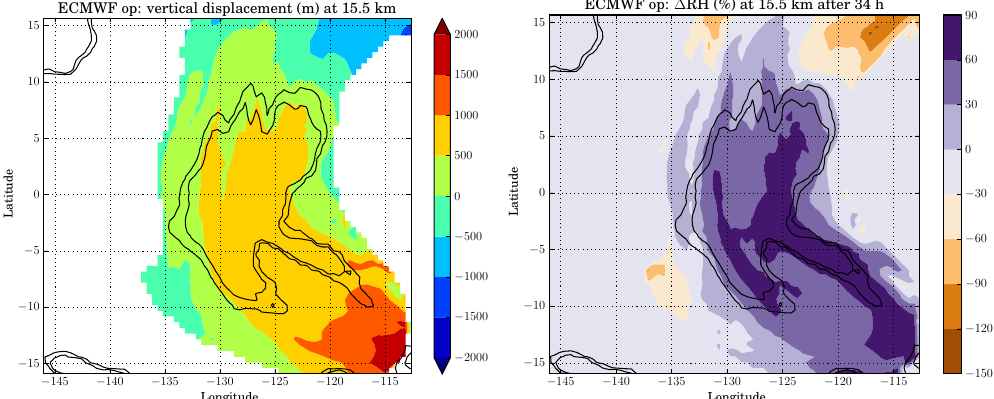
Figure 4. (Left) Lagrangian vertical displacement between the start of the simulation (27 January 2009, 00:00UTC) and 28 January 2009, 10:00, after 34h of simulation, displayed at the location of air parcels on 28 January, 10:00UTC (altitude of 15.5km). (Right) Contribution of vertical displacement to relative humidity change (cid:49) RH along a Lagrangian trajectory; see text for